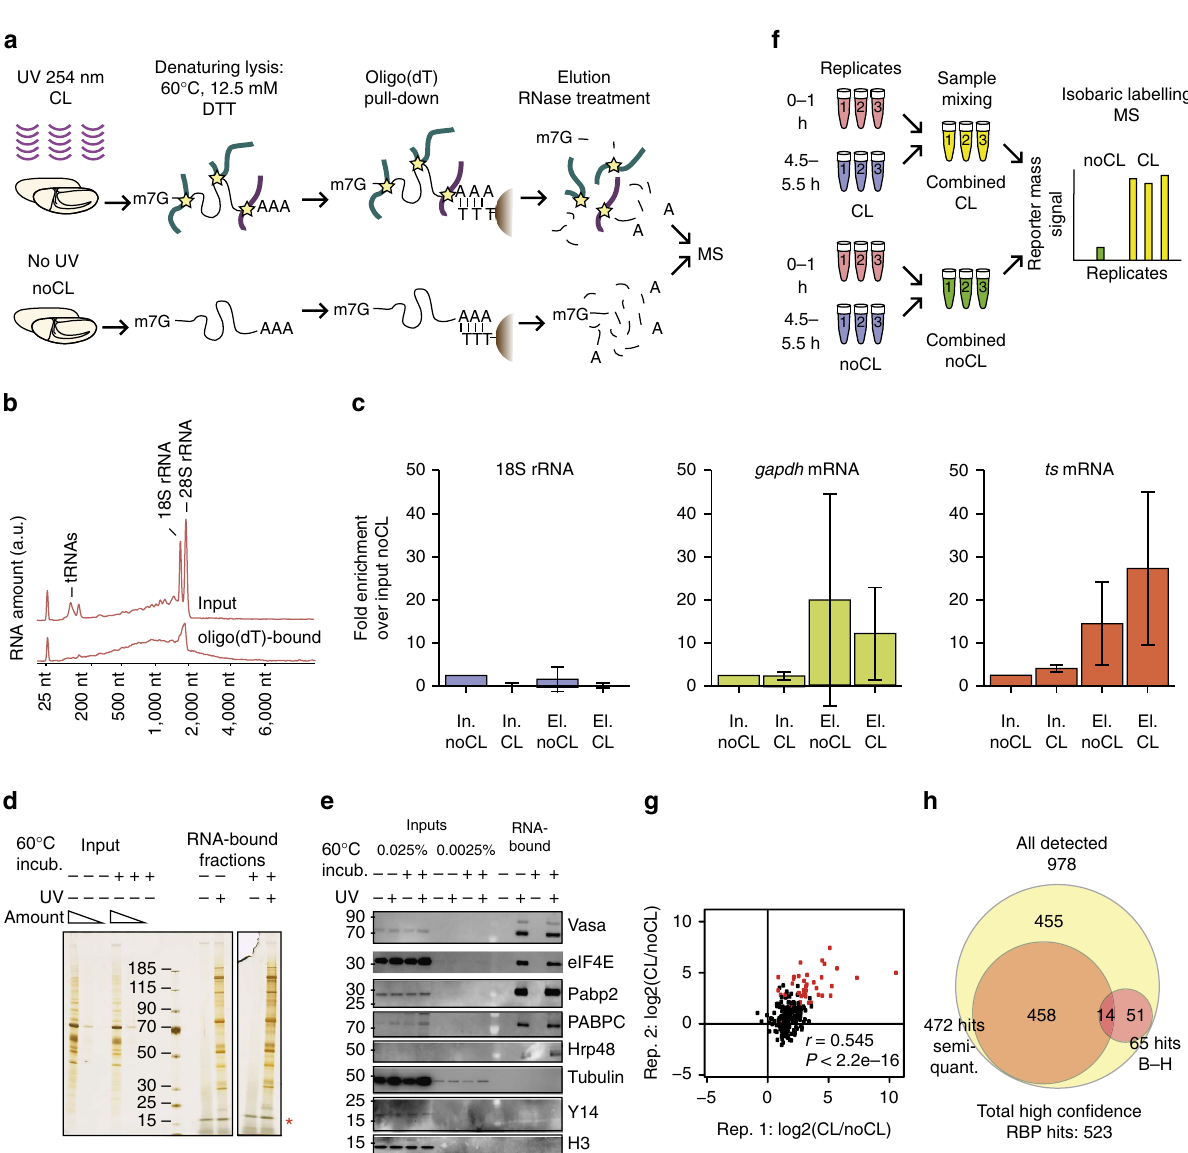
Figure 1 | Identification of the Drosophila RNA interactome. ( a ) Direct RNA binders are CL to mRNAs in living Drosophila embryos, which are subsequently lysed under denaturing conditions. mRNA-protein complexes are purified by hybridization with oligo(dT) magnetic beads and a series of stringent washes. Proteins are released by RNase treatment and are ready for MS analysis. ( b ) Analysis of total and oligo(dT) by Bioanalyzer 2100 captured RNA shows depletion of abundant ncRNAs. ( c ) Multifold enrichment of polyadenylated gapdh and ts mRNAs in oligo(dT) bound fractions confirmed by RT-qPCR. On the x axis are indicated the samples in which the amounts of the different RNAs were measured: Input noCL, input CL, eluate noCL, eluate CL. The y axis represents the fold enrichment of RNA amounts in the different samples. RNA amounts in noCL input were defined as 1. Error bars: s.d. See Supplementary Table 1 for information on oligonucleotides used for the analysis. ( d ) Protein profiles of total embryo and RNA-bound fractions. ( e ) Analysis of total embryo lysates and oligo(dT) bound fractions by western blotting with antibodies against Vasa, eIF4E, Pabp2, PABPC, Hrp48, tubulin, Y14 and H3. Lysis at 60 (cid:2) C and 12.5mM DTTensures that tubulin background is removed. See Supplementary Table 2 for antibody information. ( f ) Replicated samples prepared from pre- (0–1h) and post-MZT (4.5–5.5h) embryos are mixed to generate three aggregate CL and noCL (control) samples. Proteins are partially digested, TMT labelled and quantified by MS. ( g ) Scatter plot showing protein abundance ratios CL/noCL in two replicates. Red dots represent proteins significantly enriched in CL samples. ( h ) Venn diagram comparing numbers of detected and significantly enriched